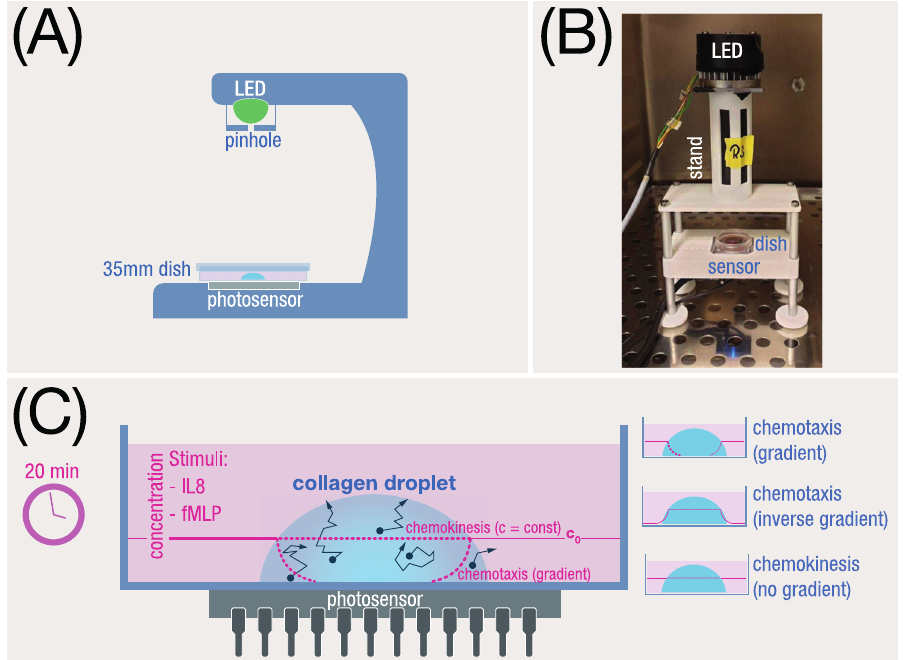
Fig 1. (A) Schematic view of the in-line holographic setup. A bright green LED produces spatially coherent light through a pinhole ( ⌀ 10 μ m in diameter). The light travels through phase objects (cells) at a different speed and direction than the undisturbed light, thereby producing diffraction patterns in the near vicinity. These patterns are recorded using a CMOS-sensor (8.6 x 6 mm, 42 MP) and later converted into 3D-images using a computer algorithm. (B) Photograph of a prototype of the holoscope in the incubator. The whole microscope is about 25 cm high, 12 cm wide and 6 cm deep; therefore, it easily fits into an incubator. (C) Submerged droplet assay: Neutrophils are